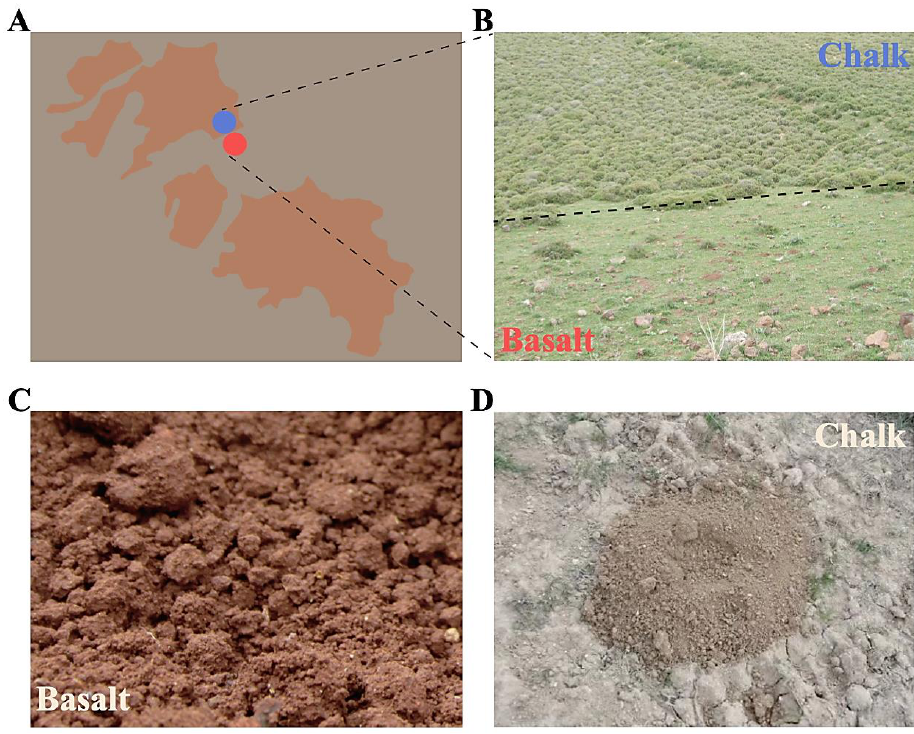
Figure 1. Geological map and ecological differences. ( A ) Geological map including the senonian chalk soil and the abutting derivative Plio-Pleistocence basalt soil, which is like reddish basaltic islands in pale chalk ocean. ( B ) The contrasting plants with only 28% of the same plant species in the different abutting soils. ( C ) The clayey wetter and milder basalt soil, and ( D ) the drier and stressful chalk soil, with a mound of the mole rat Spalax galili